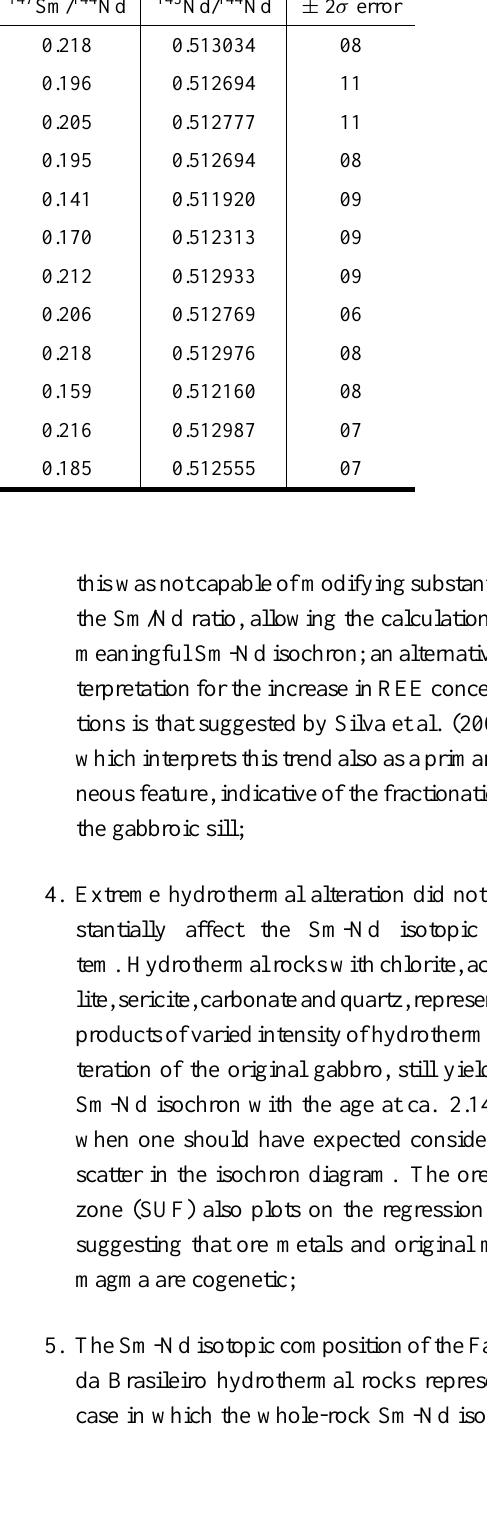
Sm-Nd isotopic data for the Fazenda Brasileiro gabbro and associated hydrothermal rocks.